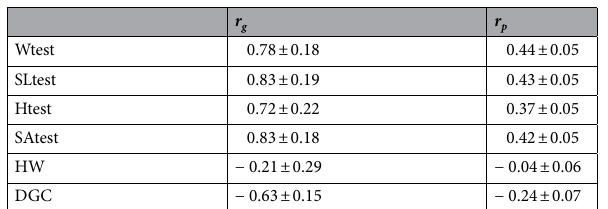
Table 3. Genetic and phenotypic correlations between absolute critical swimming speed ( U crit ) and body weight at swim testing (Wtest), standard length at swim testing (SLtest) height at swim testing (Htest), surface area at swim testing (SAtest), harvest weight (HW) and daily growth coefficient (DGC). U crit was estimated in a bivariate model without Wtest or SLtest as